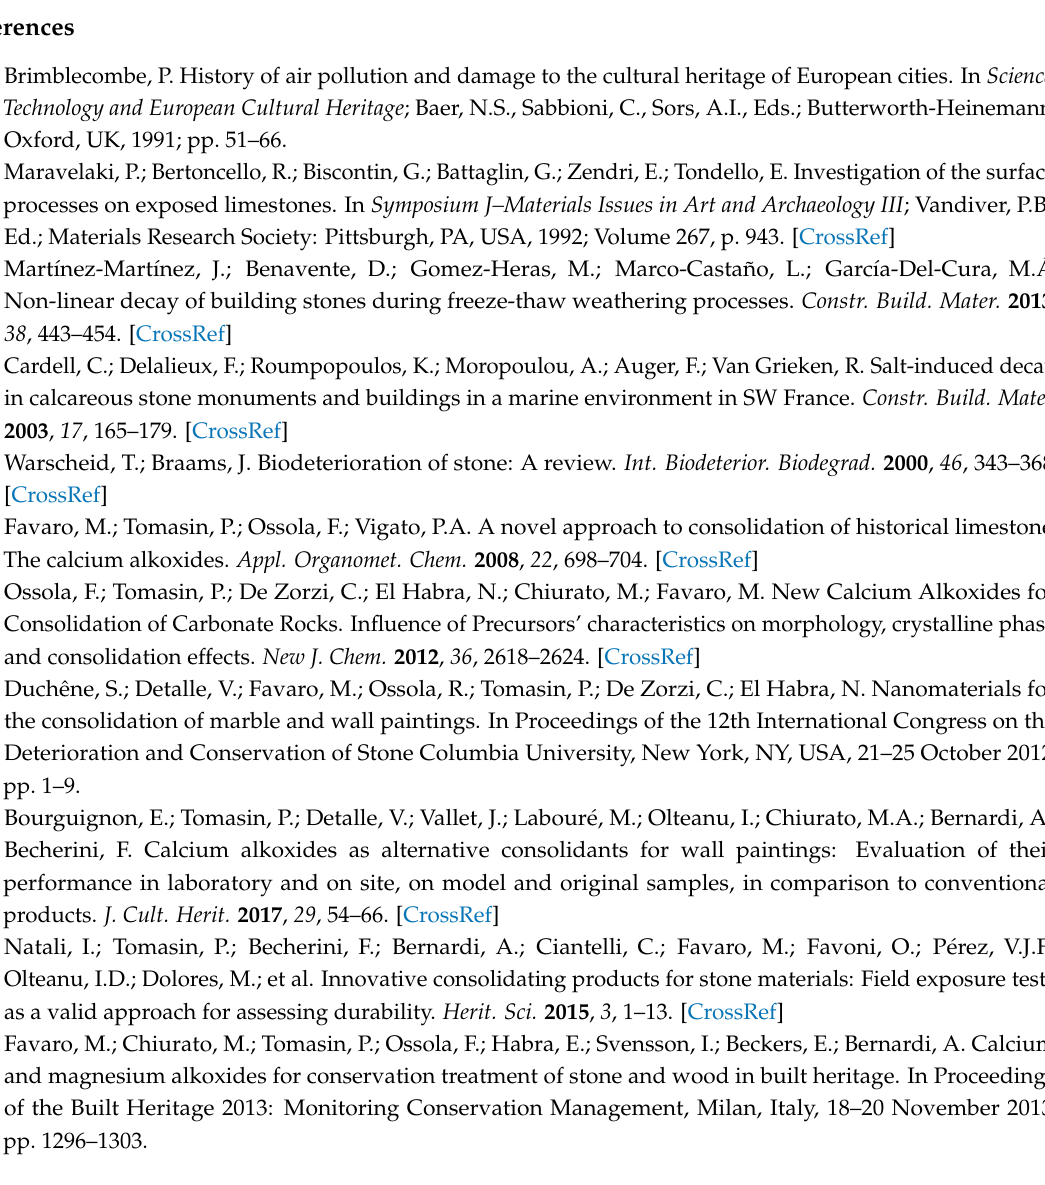
Table S1: Amount of product retained according to different types of analysis for Noto stone; Table S2: Amount of product retained according to different types of analysis for Vicenza stone; Table S3: Amount of product retained according to different types of analysis for Lecce